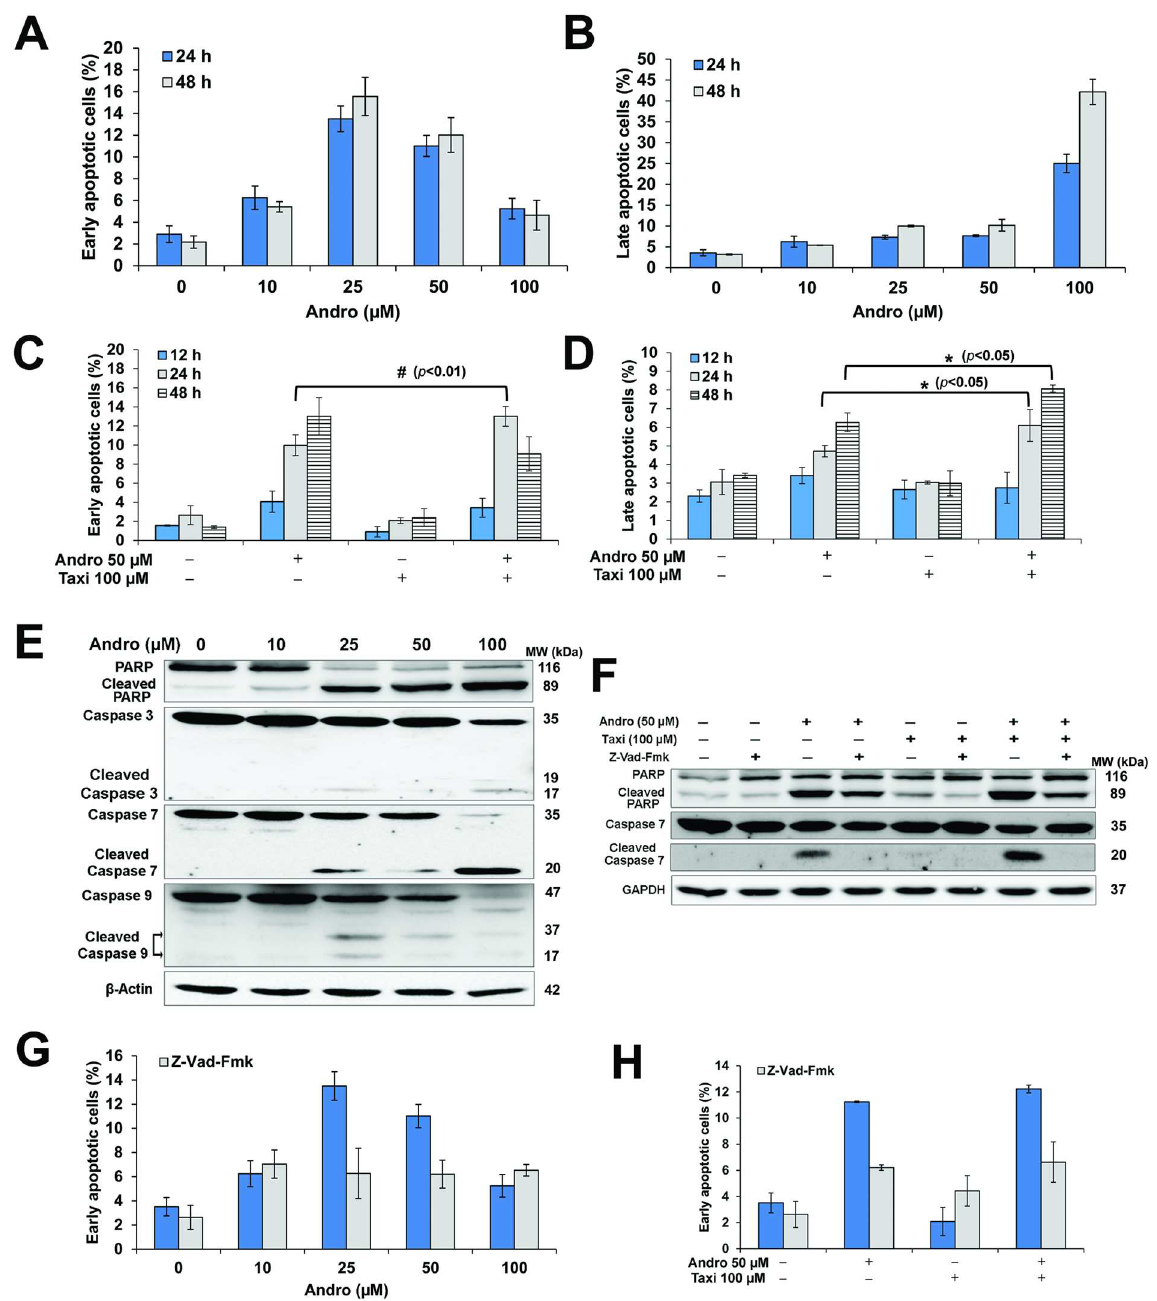
Fig 2. Effect of different concentrations of Andro and/or Taxi on Apoptosis in HeLa cells. (A, B, C & D) The mean percentages of early apoptotic; late apoptotic and dead cells treated with Andro and/or Taxi for specifiedtime. The cells were treated as indicated, then collected,stained with Yo-Pro-1 and PI and analyzedusing the flow cytometer. Results are representedas mean ± SD (n = 3). (A & B) The cells were treated with different concentrations of Andro for 24 or 48 h. (C & D) The cells were treated with Andro and/or Taxi for 12, 24 or 48 h. (E & F) Cells treated with Andro and/or Taxi for 24 h, then 50 μ g of the protein lysate were resolvedby electrophoresis and then detection of the different apoptotic proteins was done by western blotting. β -Actin and GAPDH were used to ensureequal protein loading.(E) Effect of different concentrations of Andro for 24 h on the expressionand cleavageof caspases and PARP. (F) Effect of 50 μ M Andro and/or 100 μ M Taxi alone or in the presenceof Z-Vad-Fmk for 24 h on the expression and cleavage of caspases and PARP. (G & H) The effect of the pan-caspase inhibitorZ-Vad-Fmk on apoptosisin HeLa cells treated with Andro and/or Taxi. Cells were pretreated for 1 hour with Z-Vad-Fmk (10 μ M) and then with Andro and/or Taxi for 24 h. The cells were then collectedand stainedwith Yo-Pro-1 and PI and analyzedusing the flow cytometer. Results are represented as mean ± SD (n = 3). (G) Effect of Z-Vad-Fmk on apoptosisin cells treated with different concentrations of Andro for 24 h. (H) Effect of Z-Vad-Fmk on